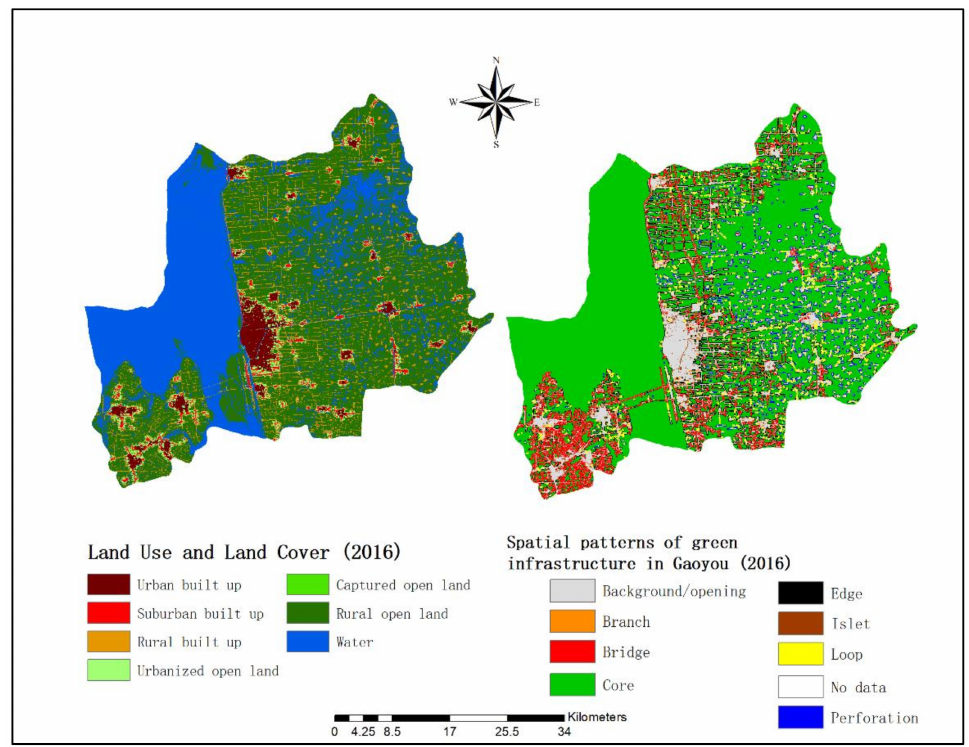
Figure 4. Morphological spatial patterns of green infrastructure in Gaoyou,